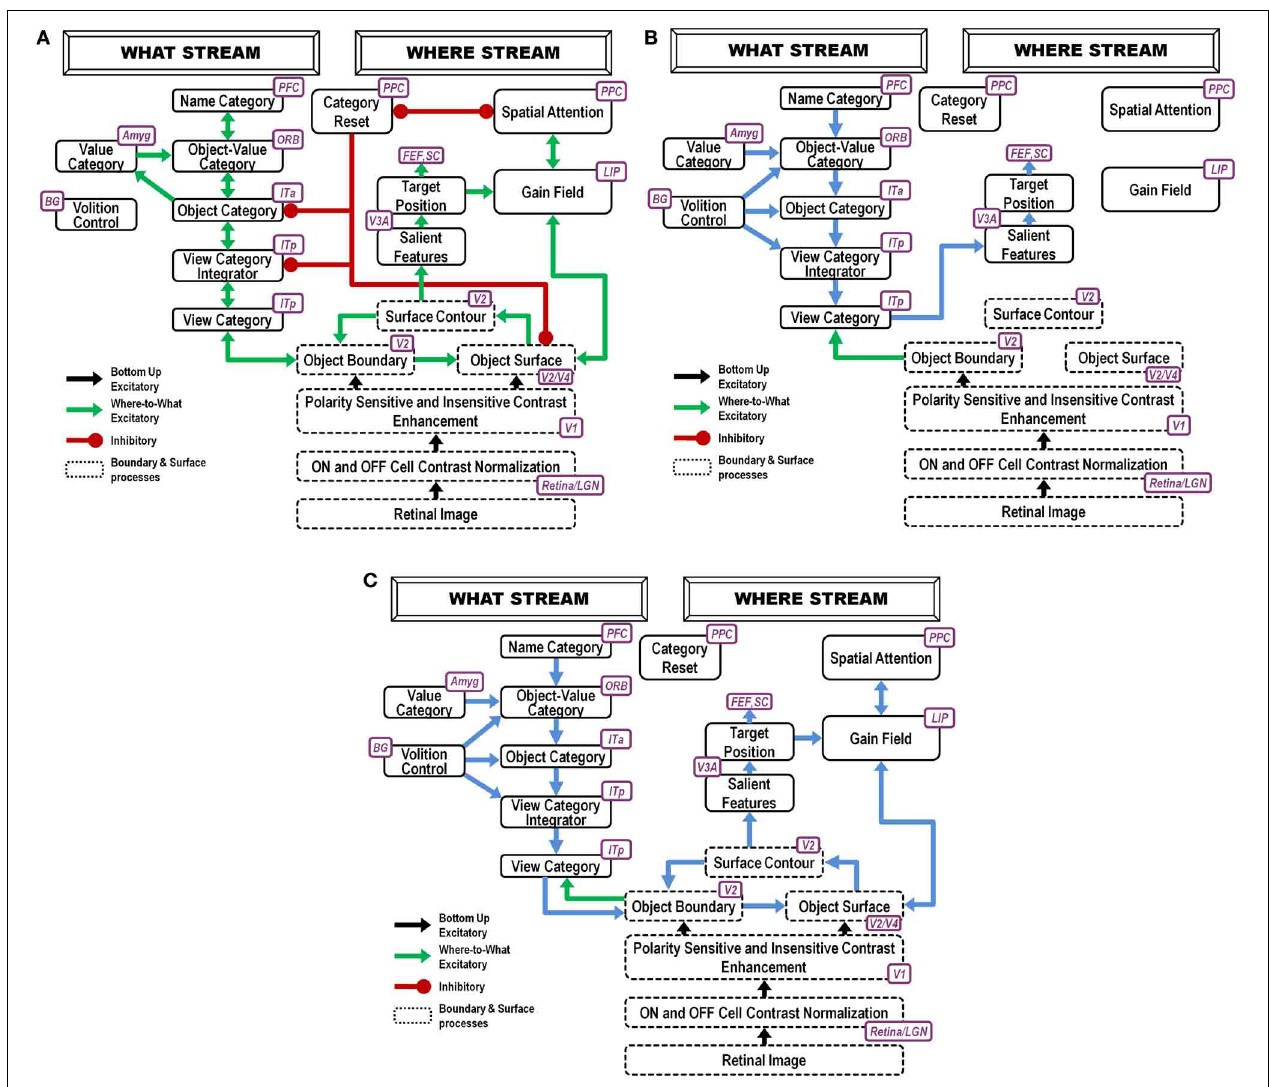
FIGURE 1 | ARTSCAN Search diagram. The dashed boxes indicate boundary and surface processes. (A) Category learning. The arrows represent the excitatory cortical processes from Where cortical stream to What cortical stream whereby invariant category learning and recognition, and reinforcement learning, occur. The connections ending in circular disks indicate inhibitory connections. (B) Direct pathway of top-down primed search from the What to the Where cortical stream. (C) Indirect pathway of top-down primed search from the What to the Where cortical stream. In both (B) and (C) , the green arrows represent